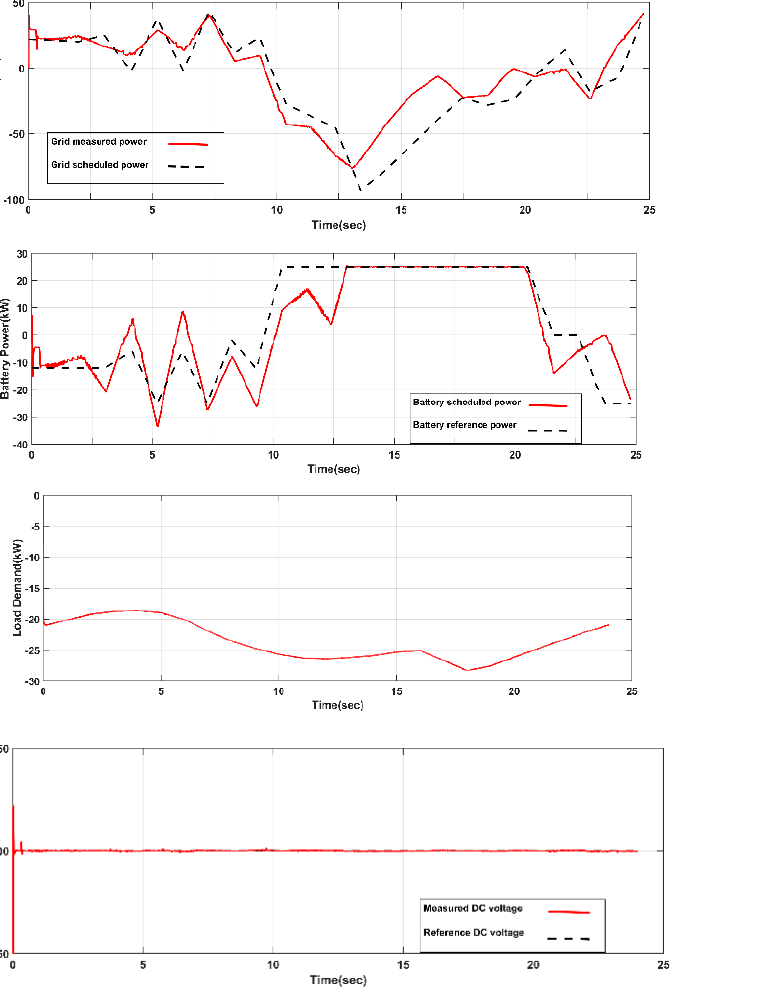
Figure 12. The output variables of the proposed MG with ( left side ) and without ( right side ) EMS in case 1.